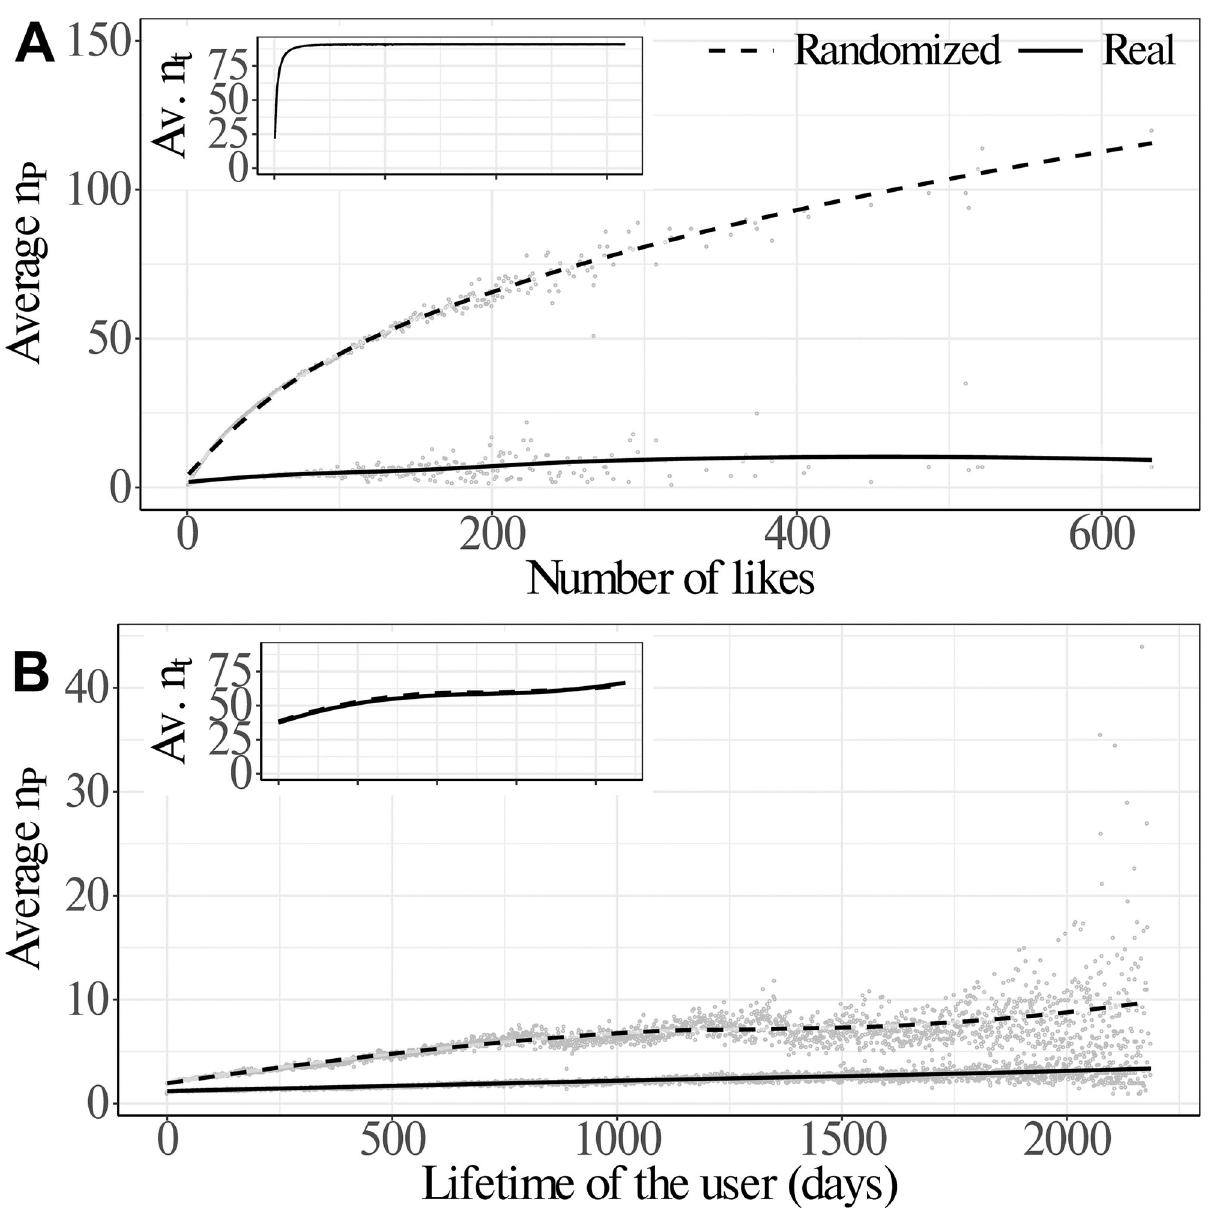
Fig 1. Correlations between users’ activity/lifetime and user engagement with pages and topics. Panel A: relationship between the average number of pages that received likes by users with respect to their activity (quantified by the number of likes). We observe that the average number of pages reaches a plateau of * 10 pages for users with an activity of more than * 300 likes. The dashed line represents the same analysis in the case of randomized data. In the inset of panel A, we show the relationship between the average number of topics covered by users with respect to their activity. We observe that users with an activity of more than * 10 likes already reach a plateau corresponding to the overall number of topics that is 91 (as explained in Materials and Methods). Panel B: relationship between the average number of pages that received likes by users with respect to their lifetime (quantified by the time between the first and the last like). We observe that the average number of pages grows slowly and reaches a value of * 3 pages for most lifelong users. The dashed line represents the same analysis in the case of randomized data. The inset of panel B, we show the relationship between the average number of topics and the users’ lifetime. We observe that for lifetime larger than * 1000 days the number of topics reaches a value of * 50, corresponding roughly to 50% of the overall topics. The curves are obtained by means of a loess regression.